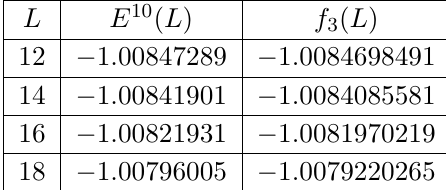
Table 12 . Extrapolated values for the vacuum energy derived by means of E 10 ( L ) and f 3 ( L ), from L = 12 to L = 18 in Schnabl